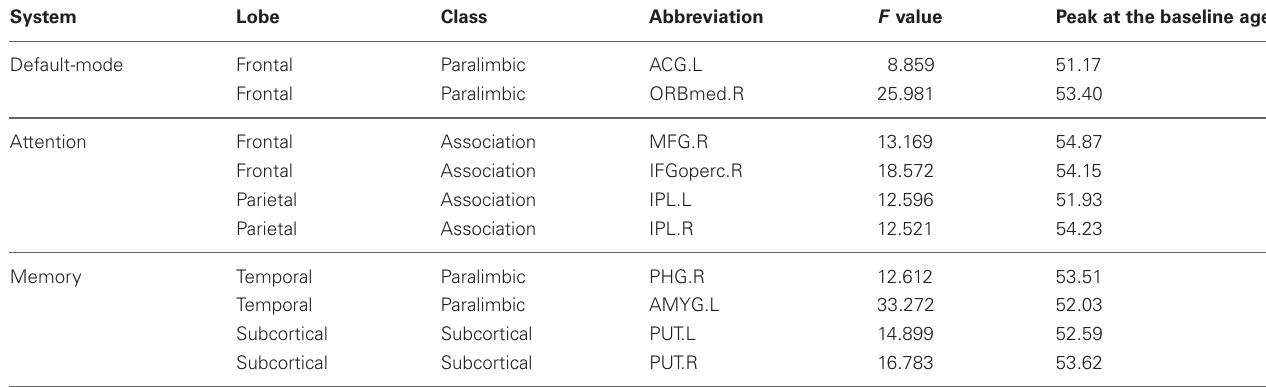
Table 3 | Significant positive quadratic correlation between the annual rate of change in node strength and the baseline